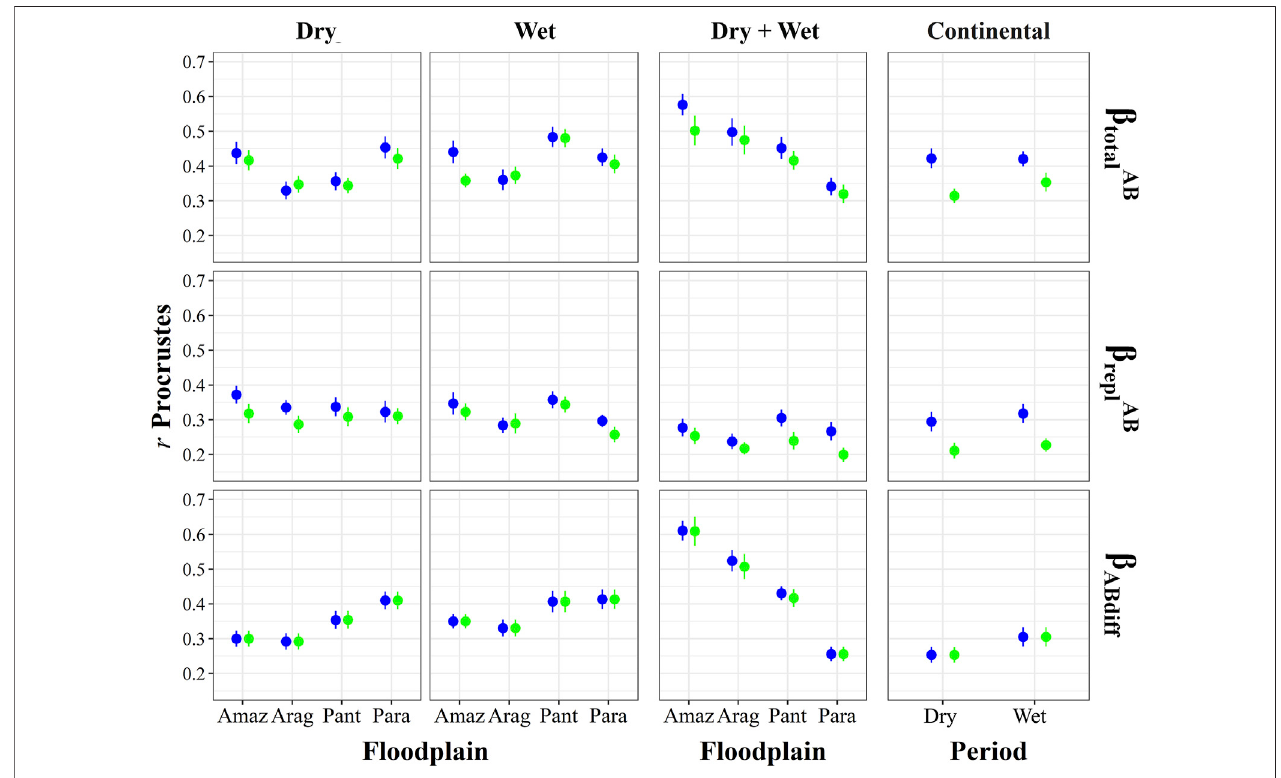
FIGURE4| Meanandstandarddeviationofcongruencecalculatedfromallpairsofcombinationsbetweenbiologicalgroupsforabundancedata.Blue,Taxonomic facet; Green, Functional facet; Amaz, Amazônia; Arag, Araguaia; Pant, Pantanal; Para,